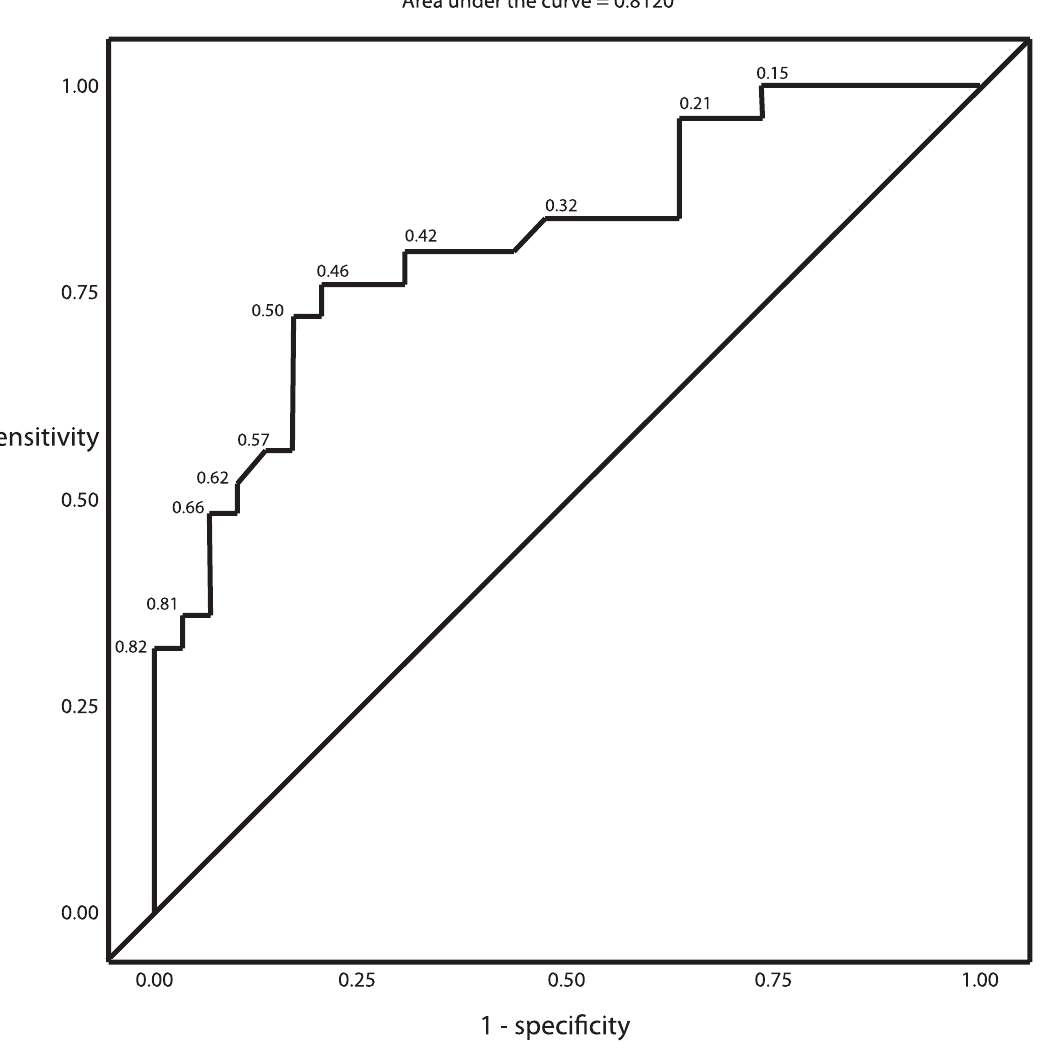
Figure 2. Receiver operating characteristic (ROC) curve associated with Stroop Interference as a discriminator between CH-NAT and CH-PAT. Area under the curve=0.81. The diagonal line represents no predictive ability of the model. Steps of the step function represent different cut-off points (labeled) for the predicted probability that a given observation is from a CH-PAT subject.